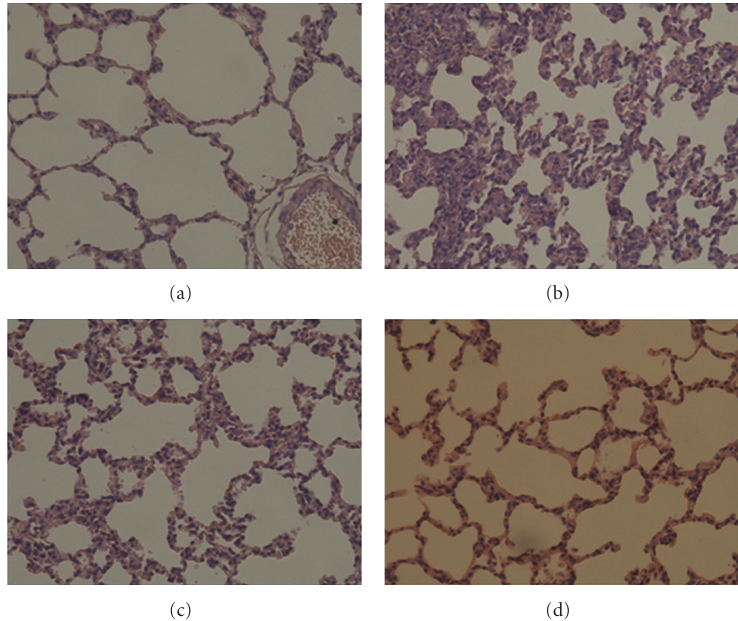
Figure 4: Photomicrographs of representative histological sections of the lung (400x magnification). (a) Control group: no treatment; (b) LPS group: endotoxemia rat model induced by LPS. (c) Posttreatment group: endotoxemia rat model treated with 5 (cid:2) -AMP. (d) Pretreatment group: rats pretreated with 5 (cid:2) -AMP prior to LPS